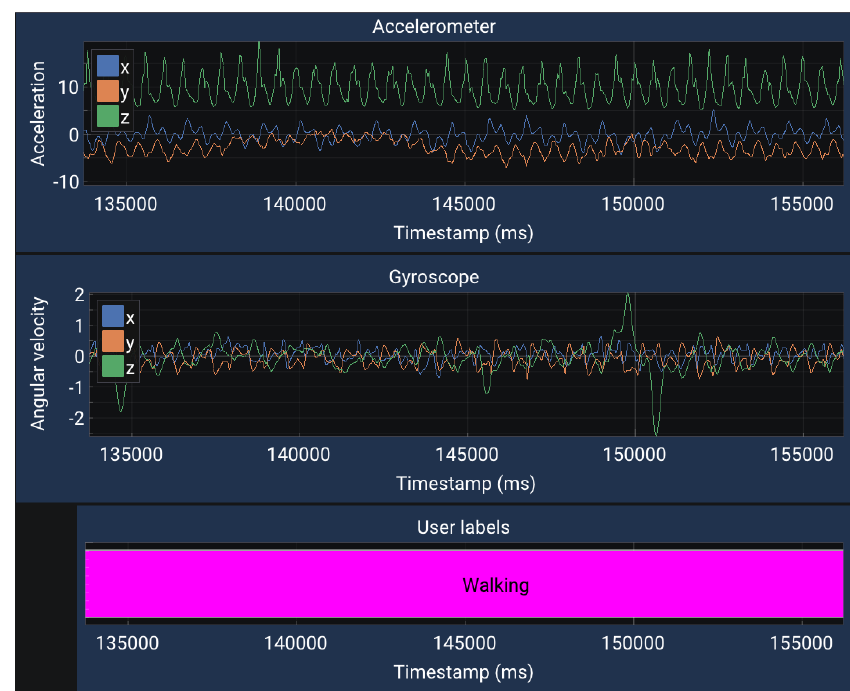
Figure A1. 20 s extracted from WALKING session of subject